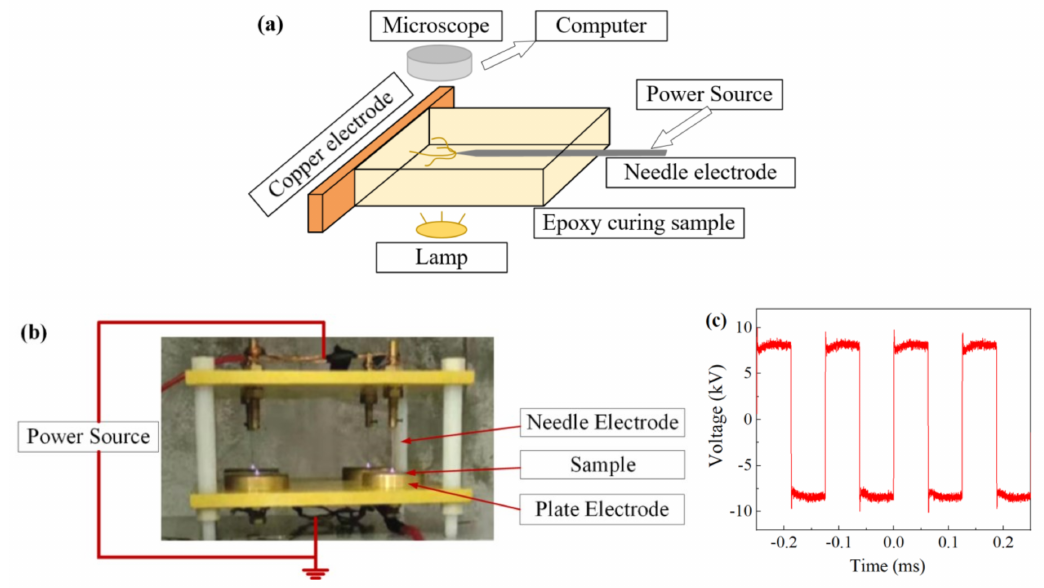
Figure 2. Schematic diagram of test platform and conditions, ( a ) the observation platform of electrical tree, ( b ) the corona test platform, ( c ) the voltage